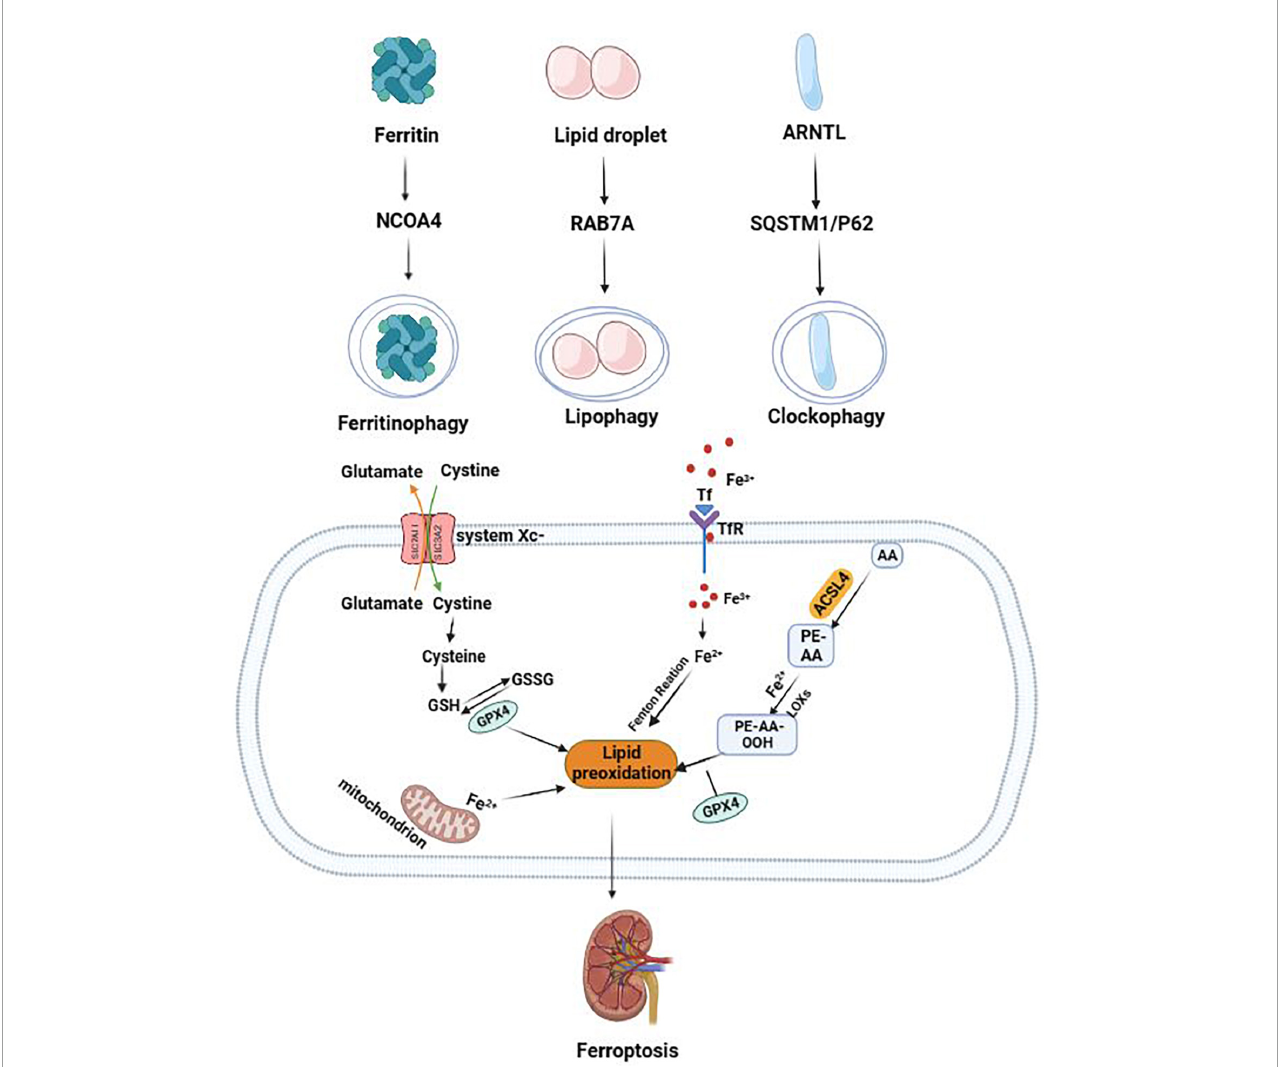
FIGURE1 The mechanism of autophagy-dependent ferroptosis. The two central events in the biochemistry of ferroptosis are lipid peroxidation and iron overload. NCOA4-mediated ferritinophagy promotes the occurrence of ferroptosis by upregulating free iron level. RAB7A-mediated lipophagy promotes the occurrence of ferroptosis by increasing lipid toxicity and lipid peroxidation levels. Clockophagy (degradation of ARNTL) promotes the occurrence of ferroptosis by regulating the redox